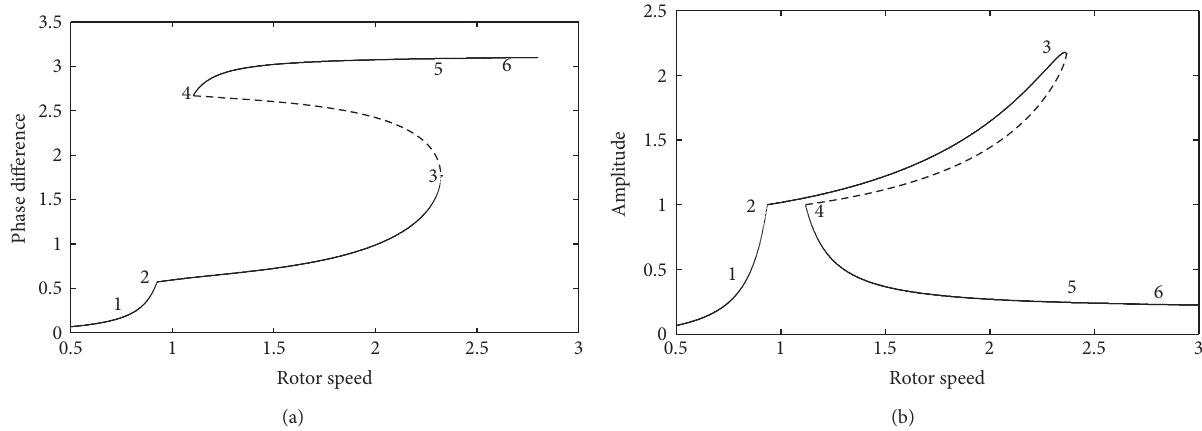
Figure 2: (a) Phase difference shift depending on rotor speed; (b) radial displacement amplitude depending on rotor speed.